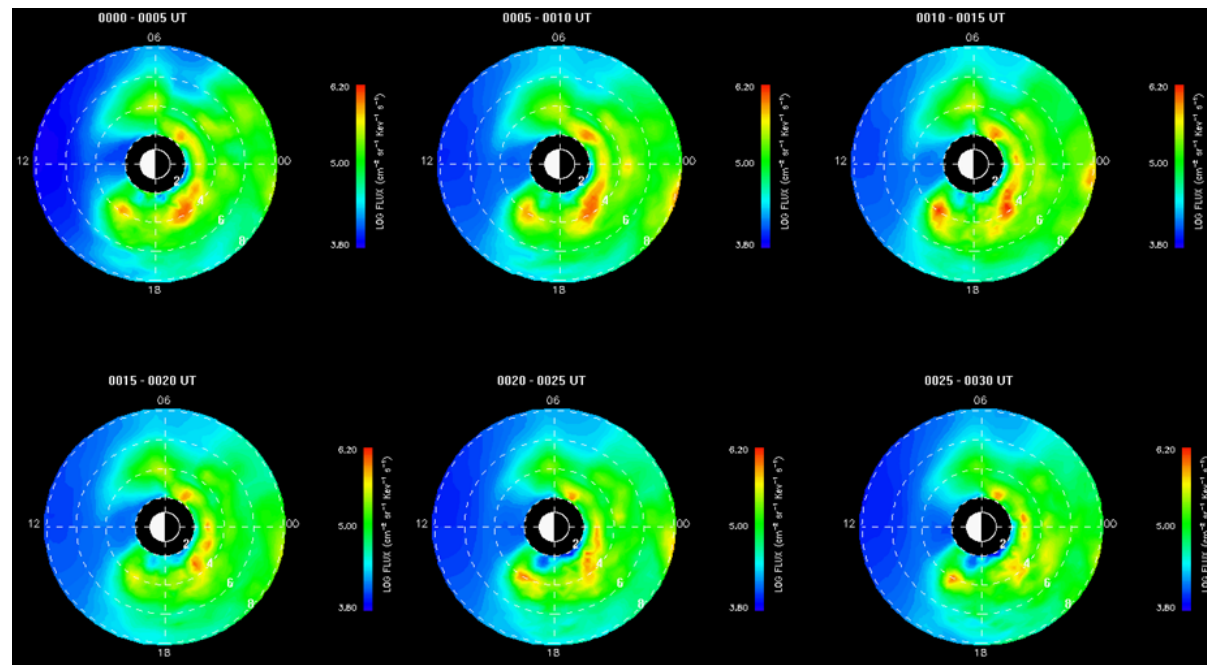
Figure 13. Fig. 13. Five minute ENA integration measurements displayed in the same format employed in the left panel of Fig. 1. The epochs are provided at the top of each panel.